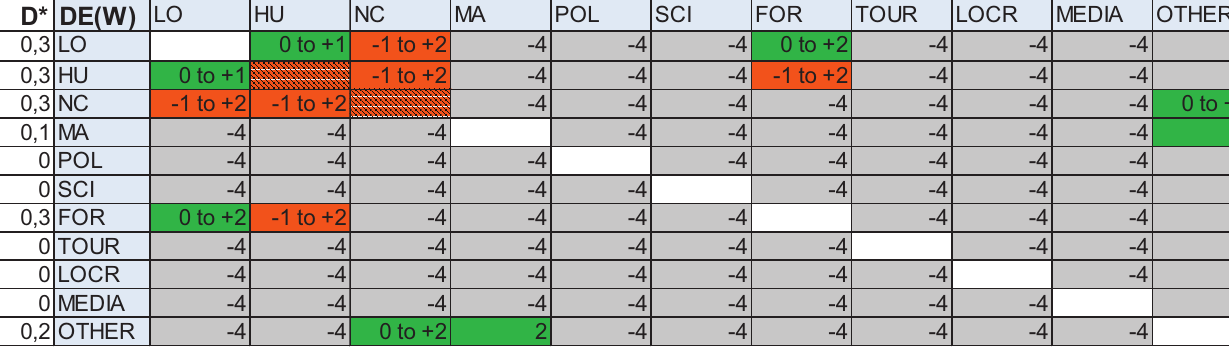
LO = Livestock owners, herders, domestic animal keepers and farmers & associations, HU = Hunters and associations, NC = Nature Conservationists, MA = Ministries and Administration, POL = Policy makers, SCI = Scientists, For = Foresters, TOUR = Tourism Sector, LOCR = Local Residents, MEDIA = Media, OTHER = Other. Green